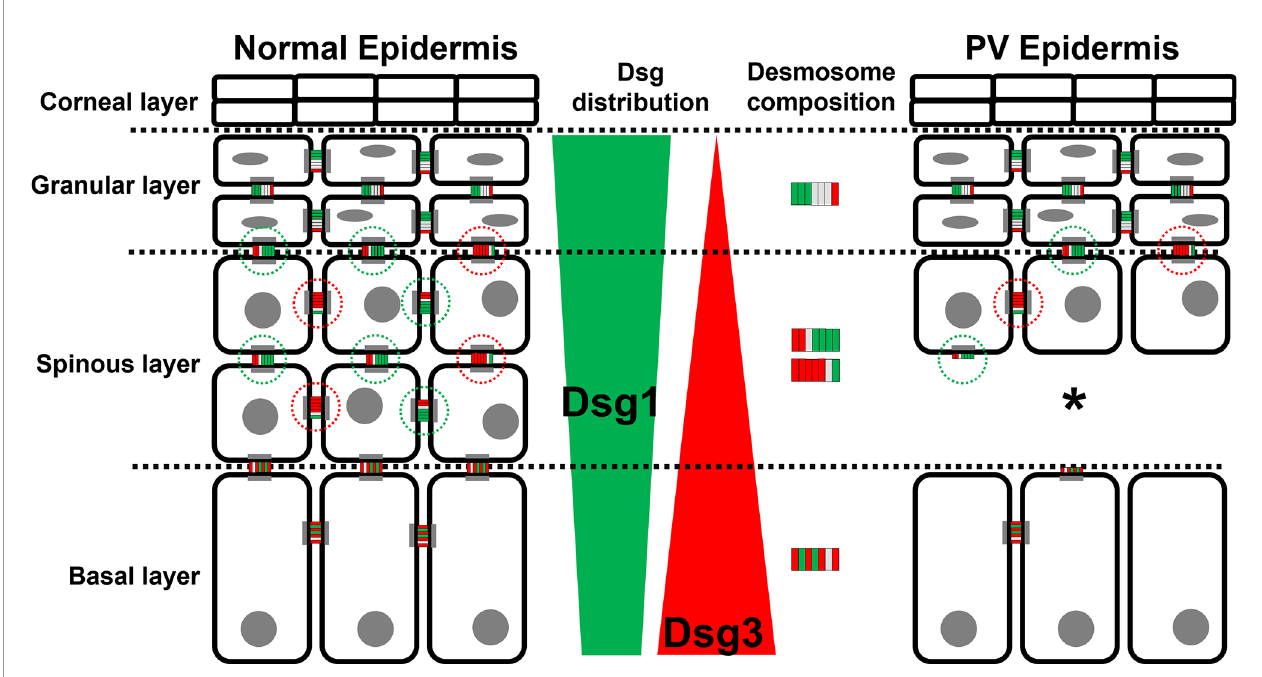
FIGURE 7 | Schematic depiction of the distribution of the PV autoantigens Dsg1 (green) and Dsg3 (red) and the composition of desmosome along different epidermal layers in normal epidermis (left) and PV-affected epidermis (right). *Signi fi cant difference to the value which is indicated that it is compared